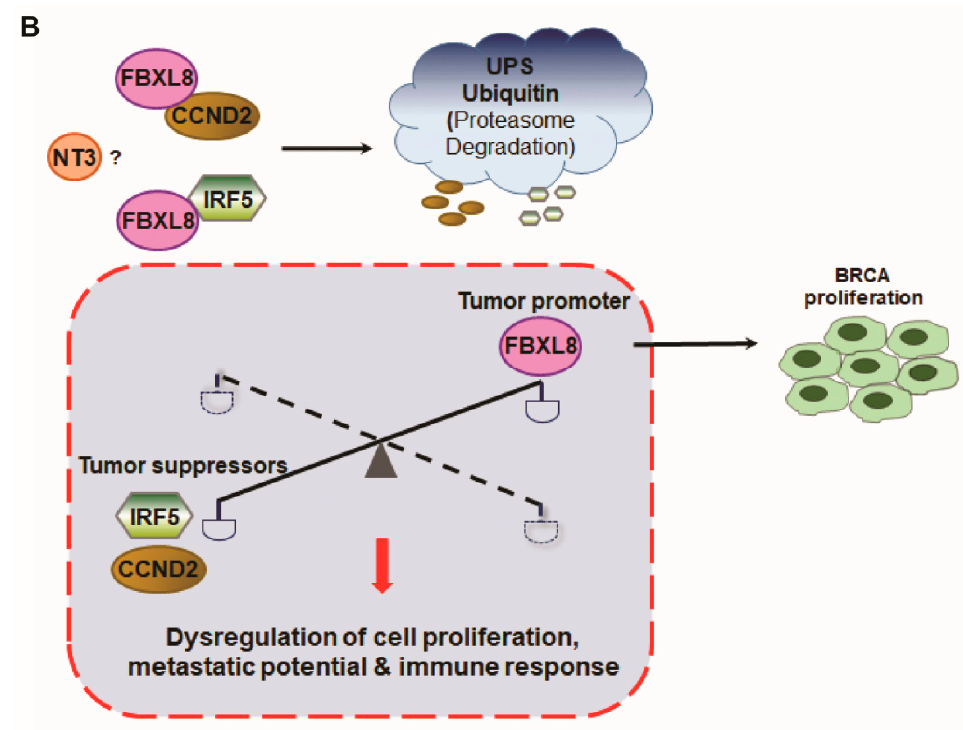
Figure 7. A hypothetical model illustrating how FBXL8 attenuates anti-cancer CCND2 and IRF5 factors, upregulates pro-tumorigenic cytokines, suppresses apoptosis and promotes metastasis potential in BRCA. FBXL8, a novel SCF E3 ubiquitin ligase, plays a key role in anti-apoptosis in BRCA. ( A ) Knockdown of FBXL8 increased expression of cancer suppressors CCND2 and IRF5, thus inhibiting cell growth and proliferation in BRCA, driven by: (i) increase in early apoptosis, (ii) activation of Caspase-9 and -3, and (iii) inhibition of the production of cancer-promoting cytokines, including MCP-1, I-TAC, TECK, CTACK, MIF, GM-CSF, NT-3, FGF-6, Angiogenin, ICAM-1, DtK and EGFR. Therefore, FBXL8 promotes pro-tumorigenic microenvironment, contributing to BRCA metastasis and progression. ( B ) FBXL8 interacts and downregulates cancer suppressors CCND2 and IRF5 via protein degradation system. Hence, upregulated FBXL8 in BRCA causes the reduction of CCND2 and IRF5 proteins, and leads to dysregulated cell proliferation, immune response and metastatic potential of BRCA cells.